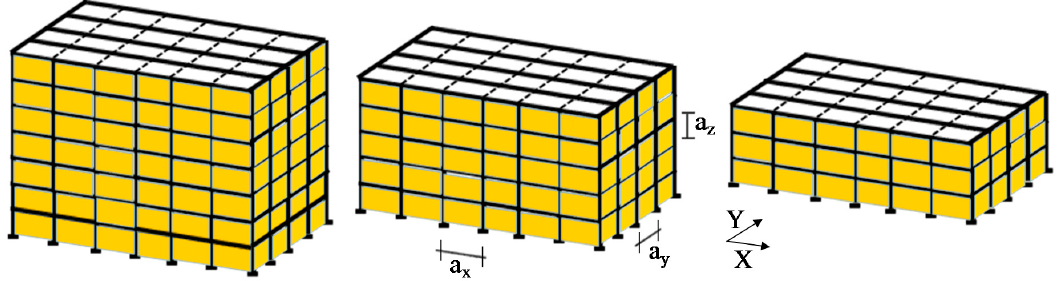
Figure 7. Scheme of the archetype buildings considered for the analyses.